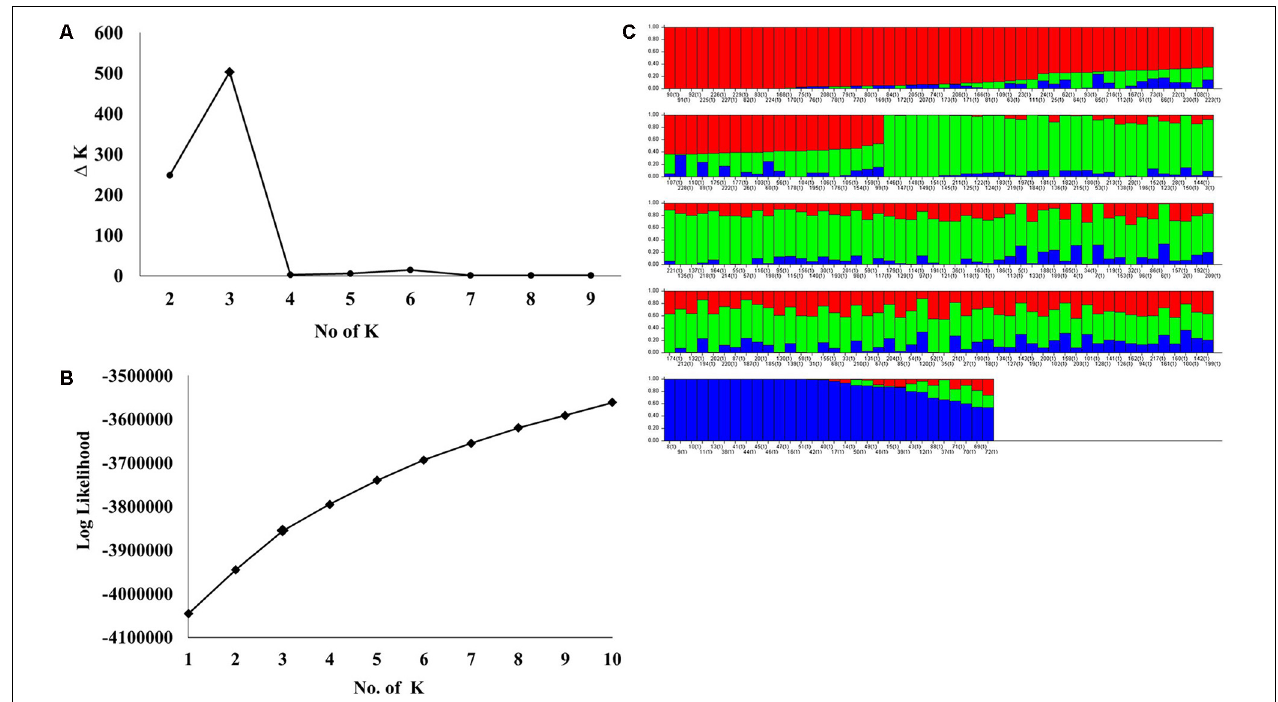
FIGURE 3 | (A) Delta ( (cid:49) )K for differing numbers of subpopulations ( k ), (B) the average of log-likelihood value and (C) estimated population structure of 230 wheat genotypes on ( k = 3), G refers to subpopulation using STRUCTURE.